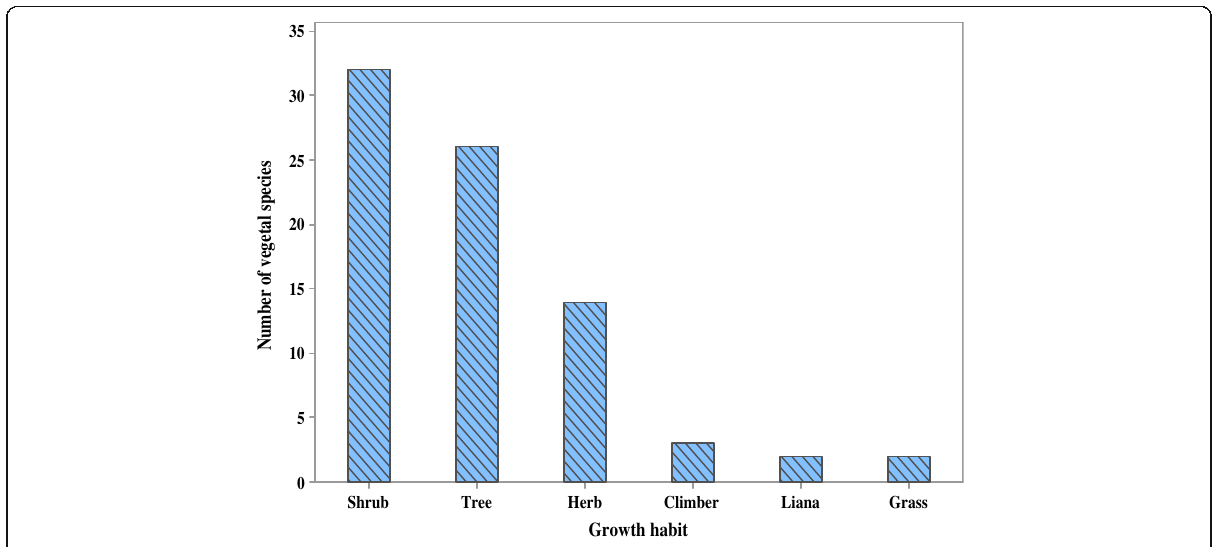
Fig. 4 Growth habit of the antivenin plants used in rural communities of